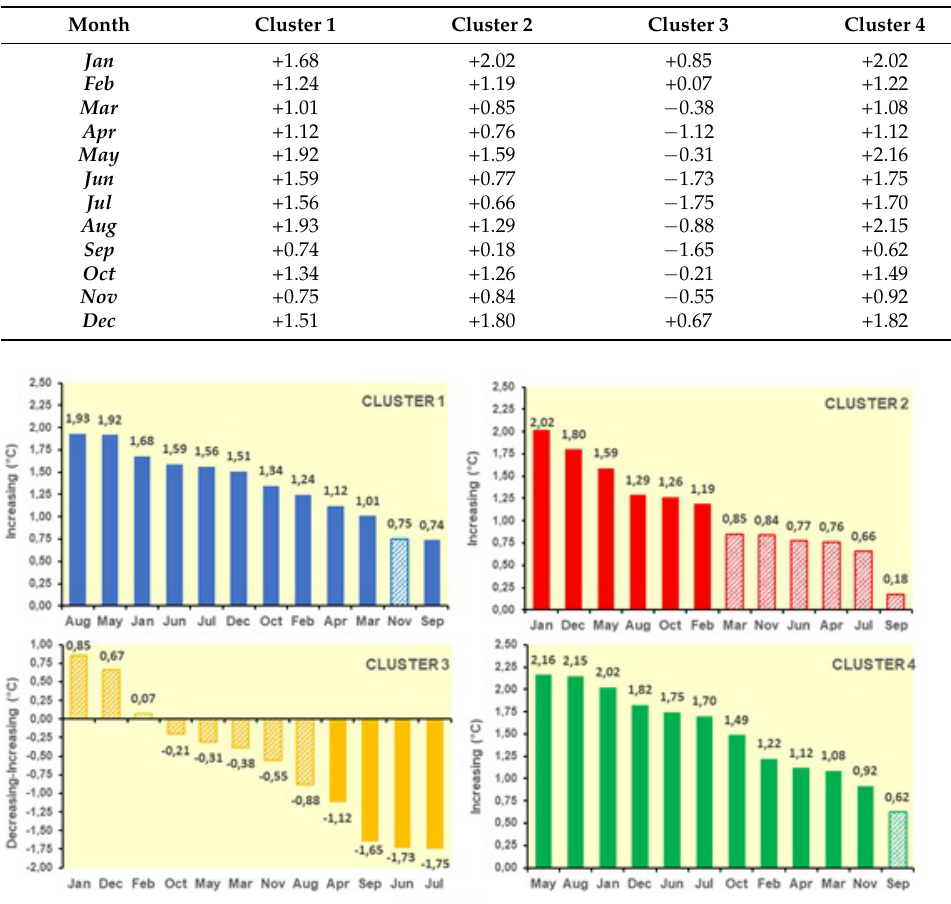
Table 2. Rates of variation of temperature trends in ( ◦ C).